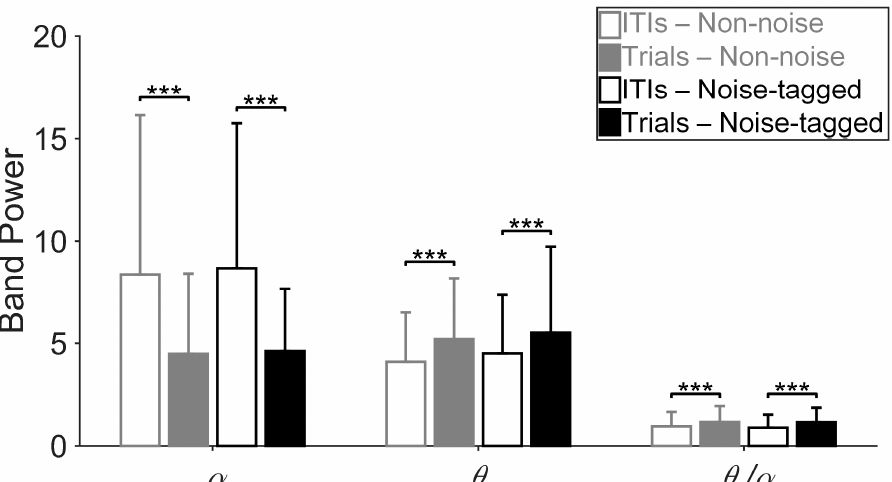
Figure 4. Comparison of mental load indices between non-task ITIs and on-task trials in both non-noise and noise-tagged conditions across participants. The mean values and standard deviation (SD) of α and θ powers and the θ / α ratio were calculated across twelve participants. All statistics were assessed by one-way ANOVA, *** p < 0.001 between non-task ITIs and on-task trials in both non-noise and noise-tagged BCI applications.